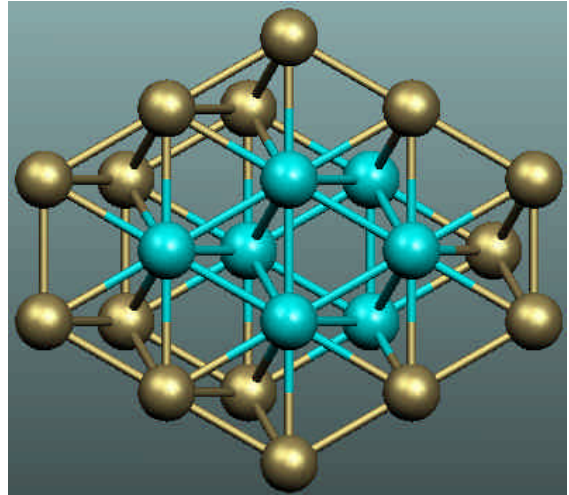
Figure 1. Top view of the Au